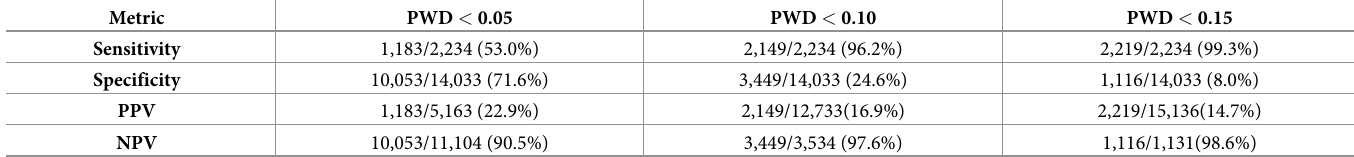
Table 1. Sensitivity, specificity, Positive Predictive Value (PPV), and Negative Predictive Value (NPV) of PWD thresholds for DepMap essential gene identification.